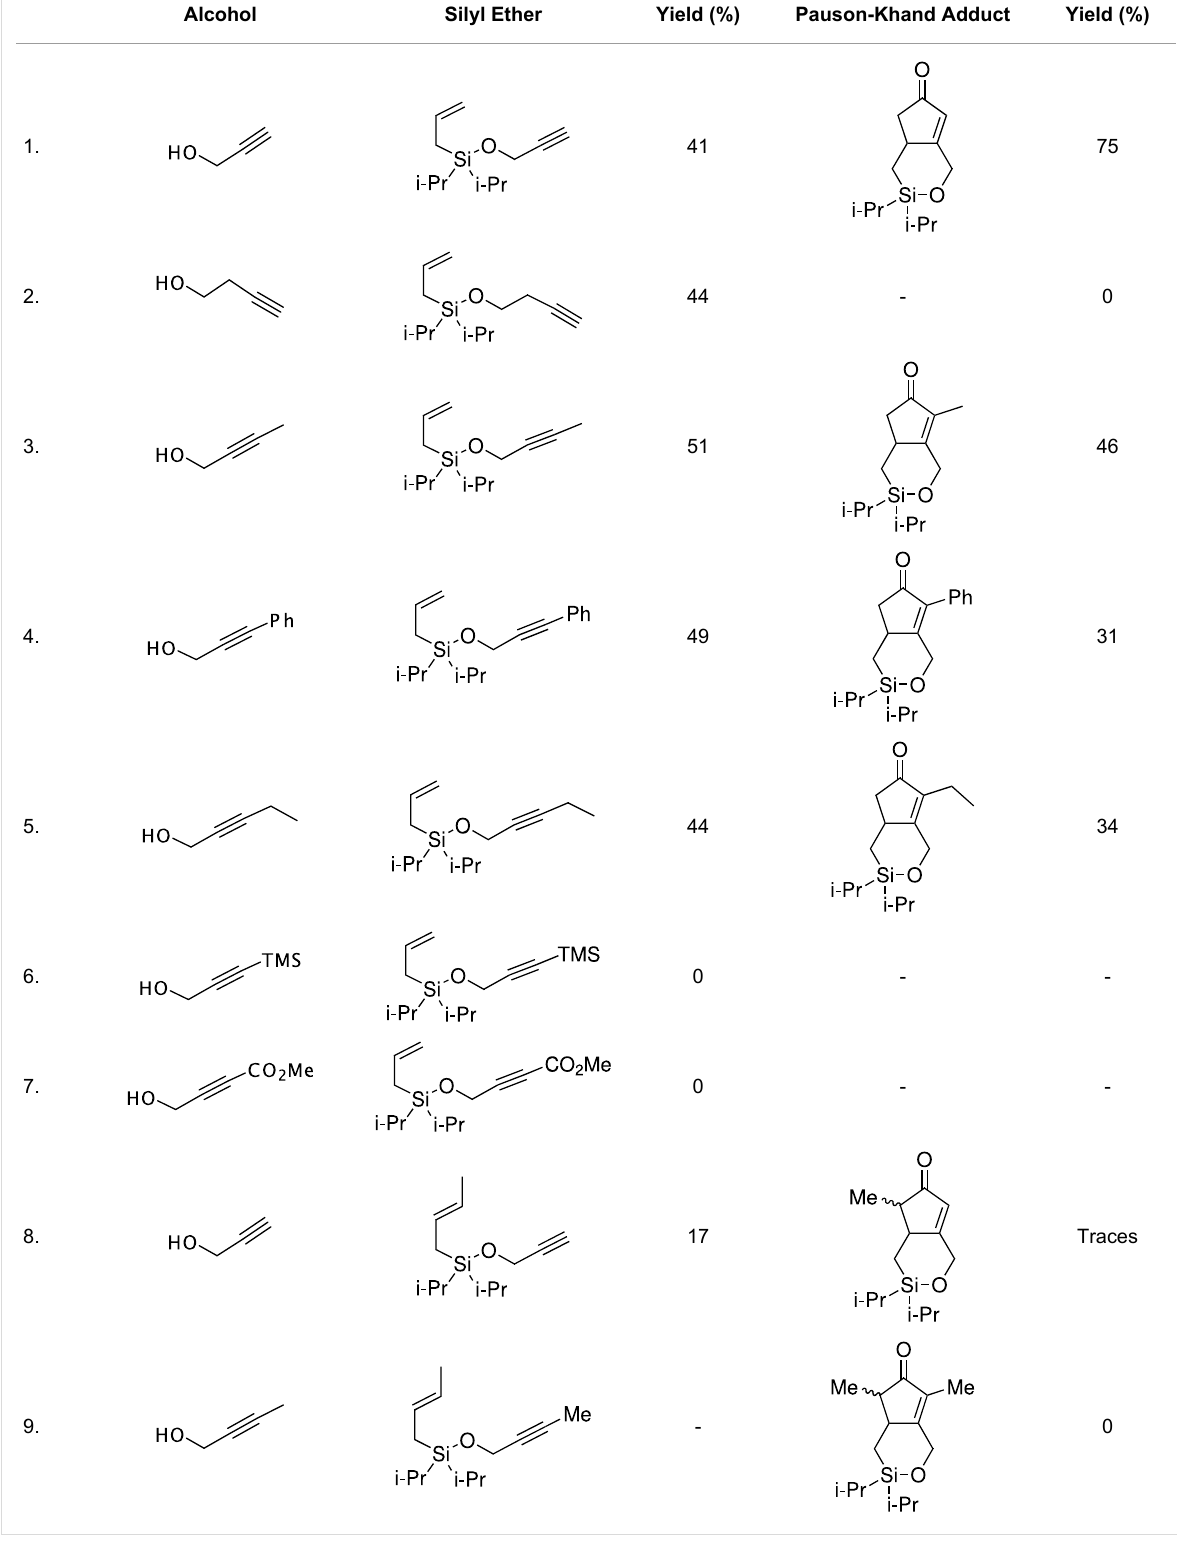
Table 1: Di iso propylsilyl ether formation and subsequent Pauson-Khand